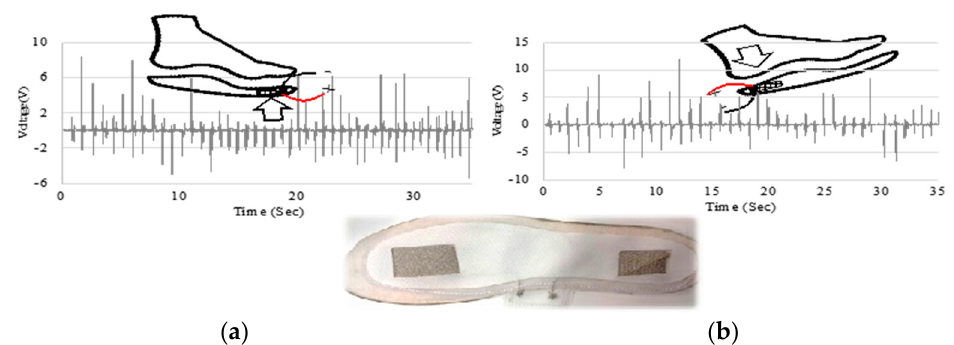
Figure 7. ( a ) Output voltage of the PSTS pressing by toe. ( b ) Output voltage of the PSTS pressing by heel.